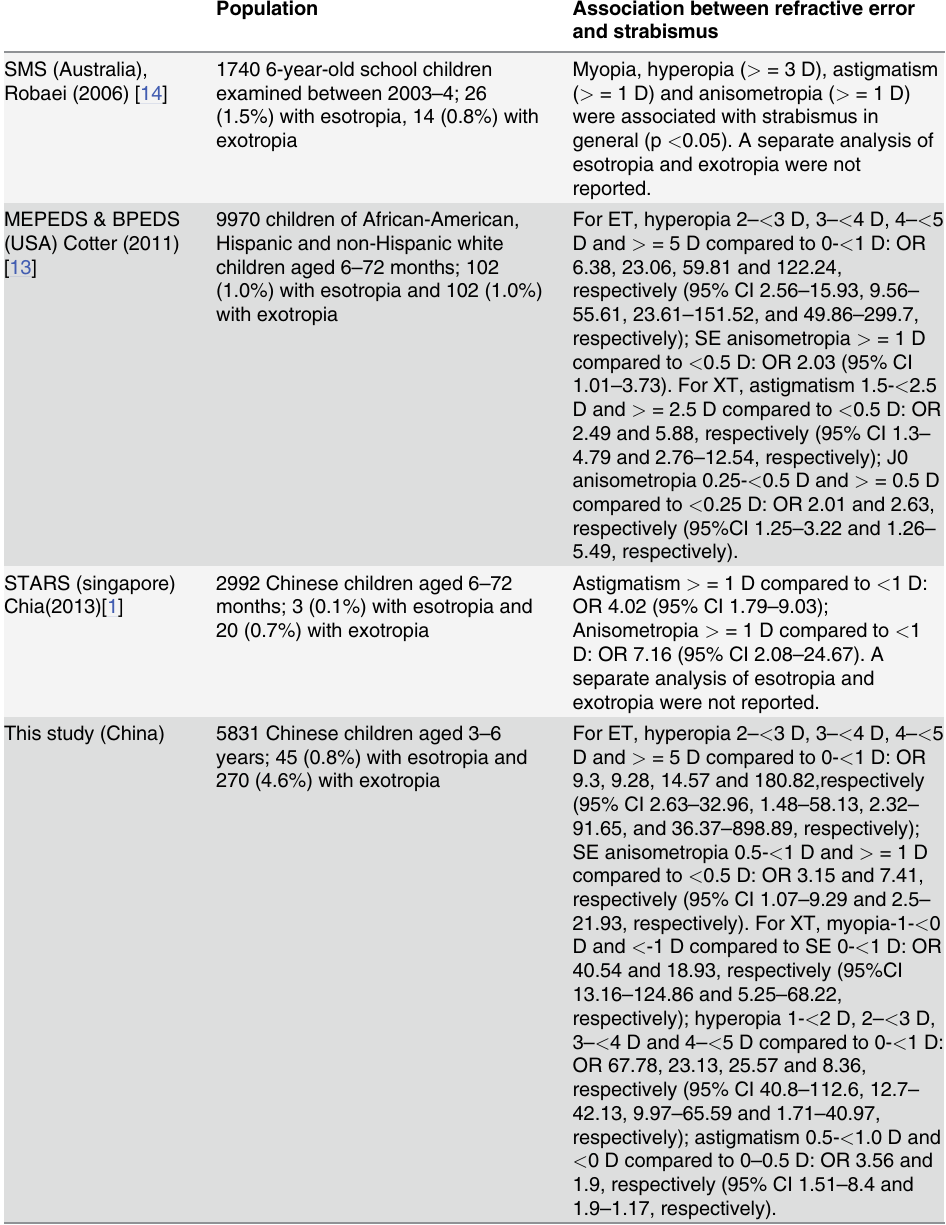
Table 4. Review of Population-based Studies of Association between Refractive error and